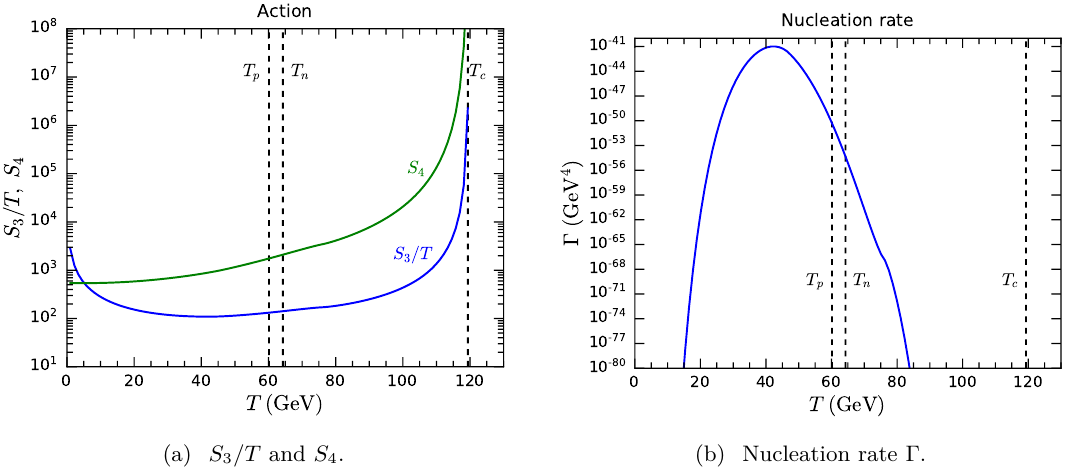
Figure 2 . The actions S 3 /T and S 4 (a) and the nucleation rate Γ (b) as functions of the temperature T for BP3. The dashed lines denote the critical, nucleation, and percolation temperatures T c , T n , and T p